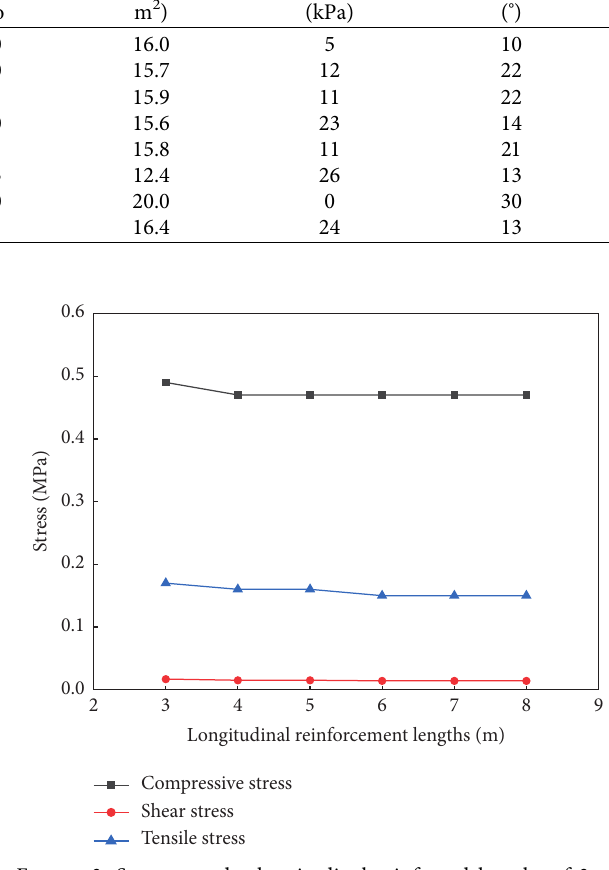
Figure 3: Stresses under longitudinal reinforced lengths of 3 m, 4 m, 5m, 6 m, 7m, and